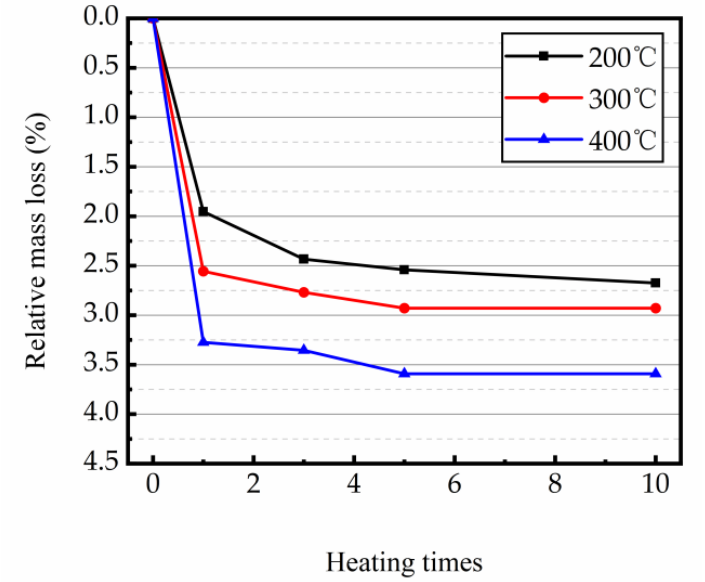
Figure 6. Relative mass loss of magnetite concrete at high temperature with repeated heating.